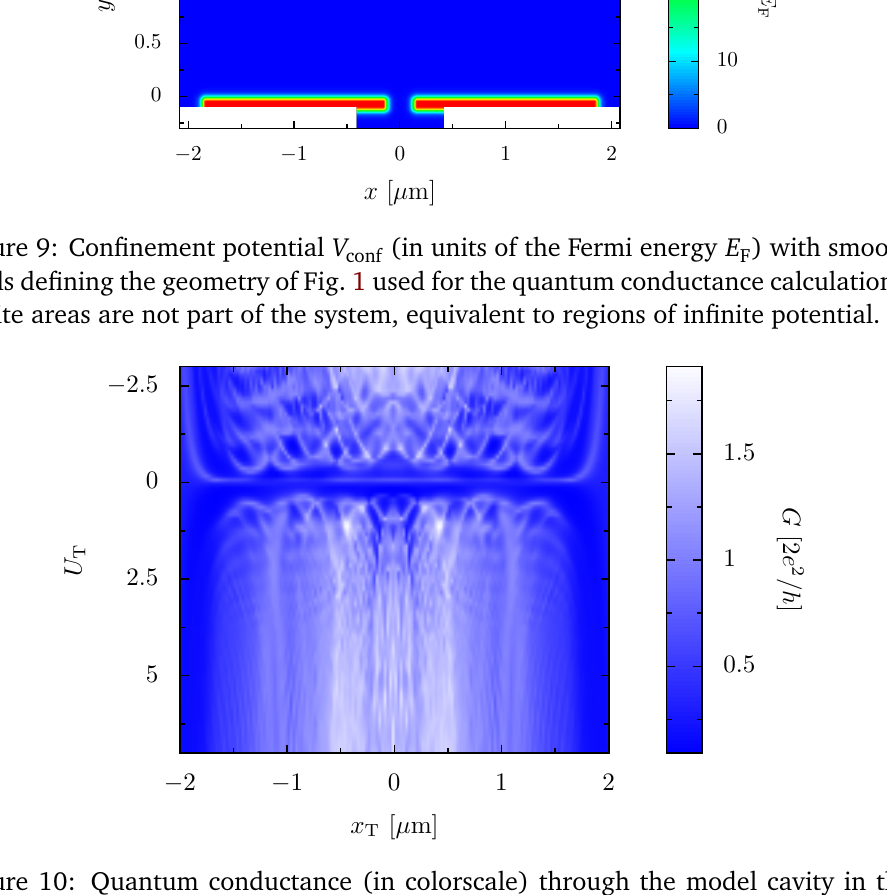
= 1.625 µ m, and at fixed y T T T